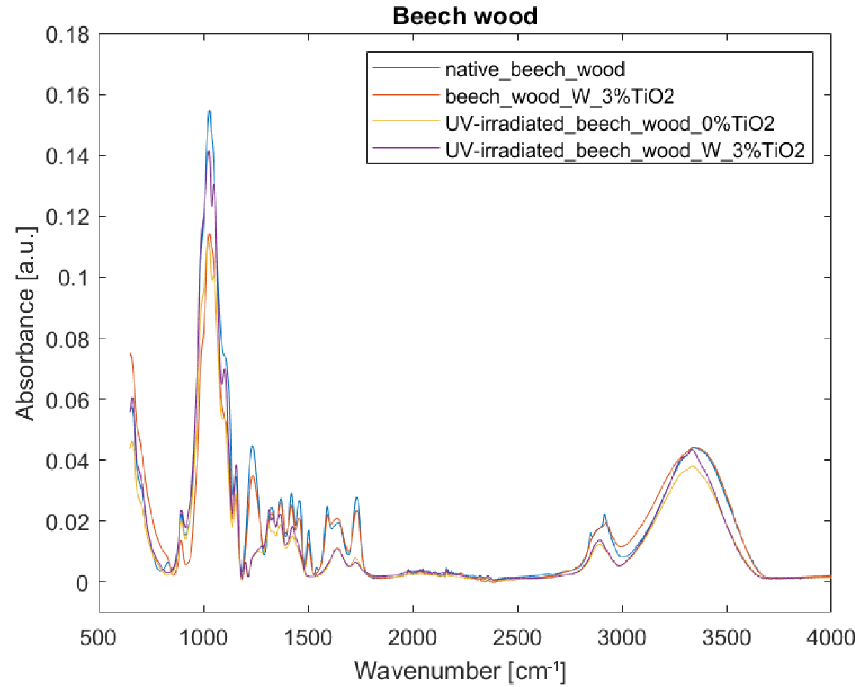
Figure 7. FTIR-ATR spectra of beech wood samples: (blue) reference sample of native beech wood, (red) beech wood with 3% TiO 2 coating with water as binder, (yellow) UV-irradiated beech wood without TiO 2 coating, and (purple) UV-irradiated beech wood with 3% TiO 2 coating with water as binder.